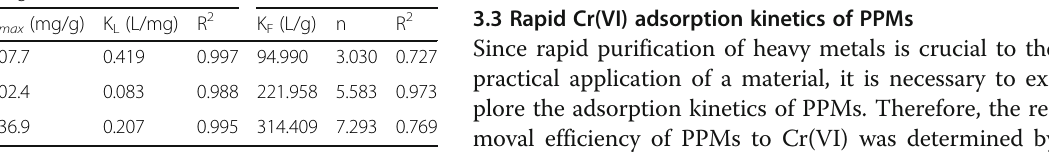
Table 1 Fitting parameters of thermodynamic adsorption under different temperatures Materials T Langmuir (K)